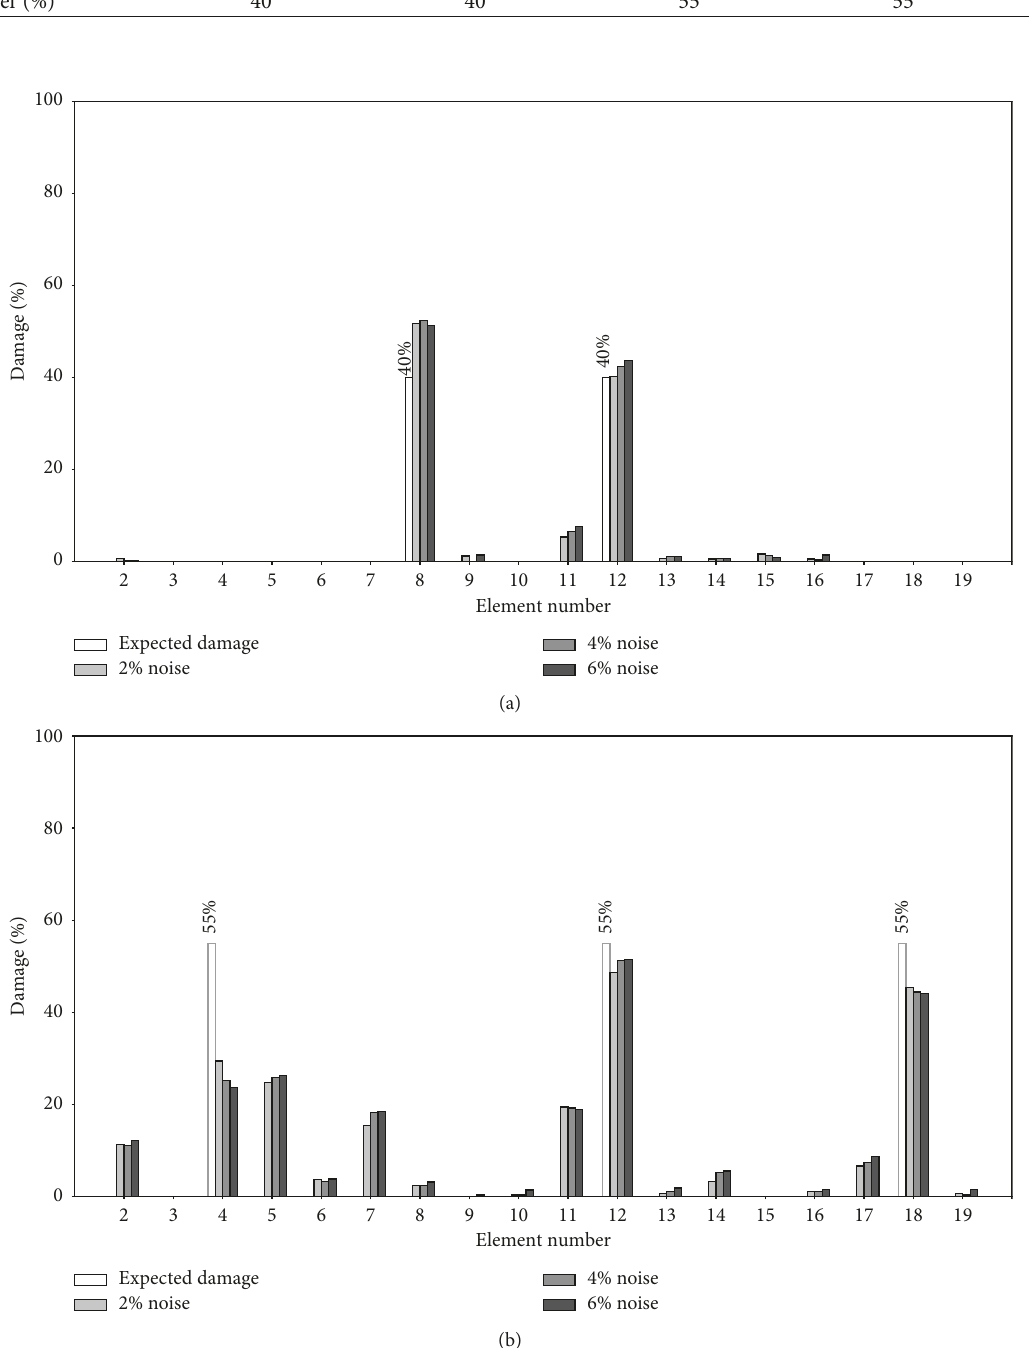
Figure 25: Noise robustness for model 2 (a) and model 3